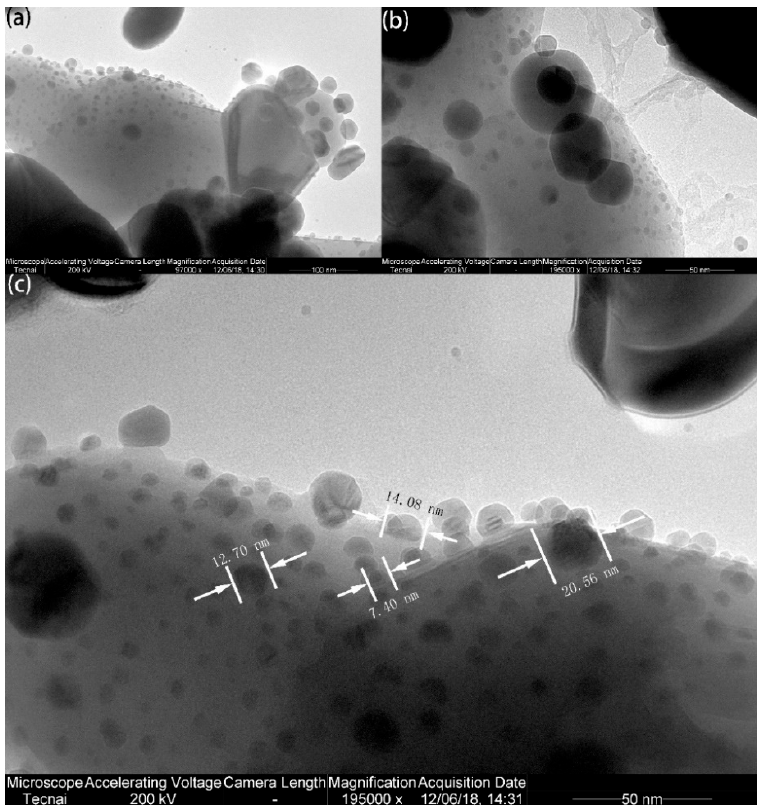
Figure 8. TEM images of AgI/ZnO (X = 0.4). ( a ) 100 nm, ( b , c ) 50 nm.